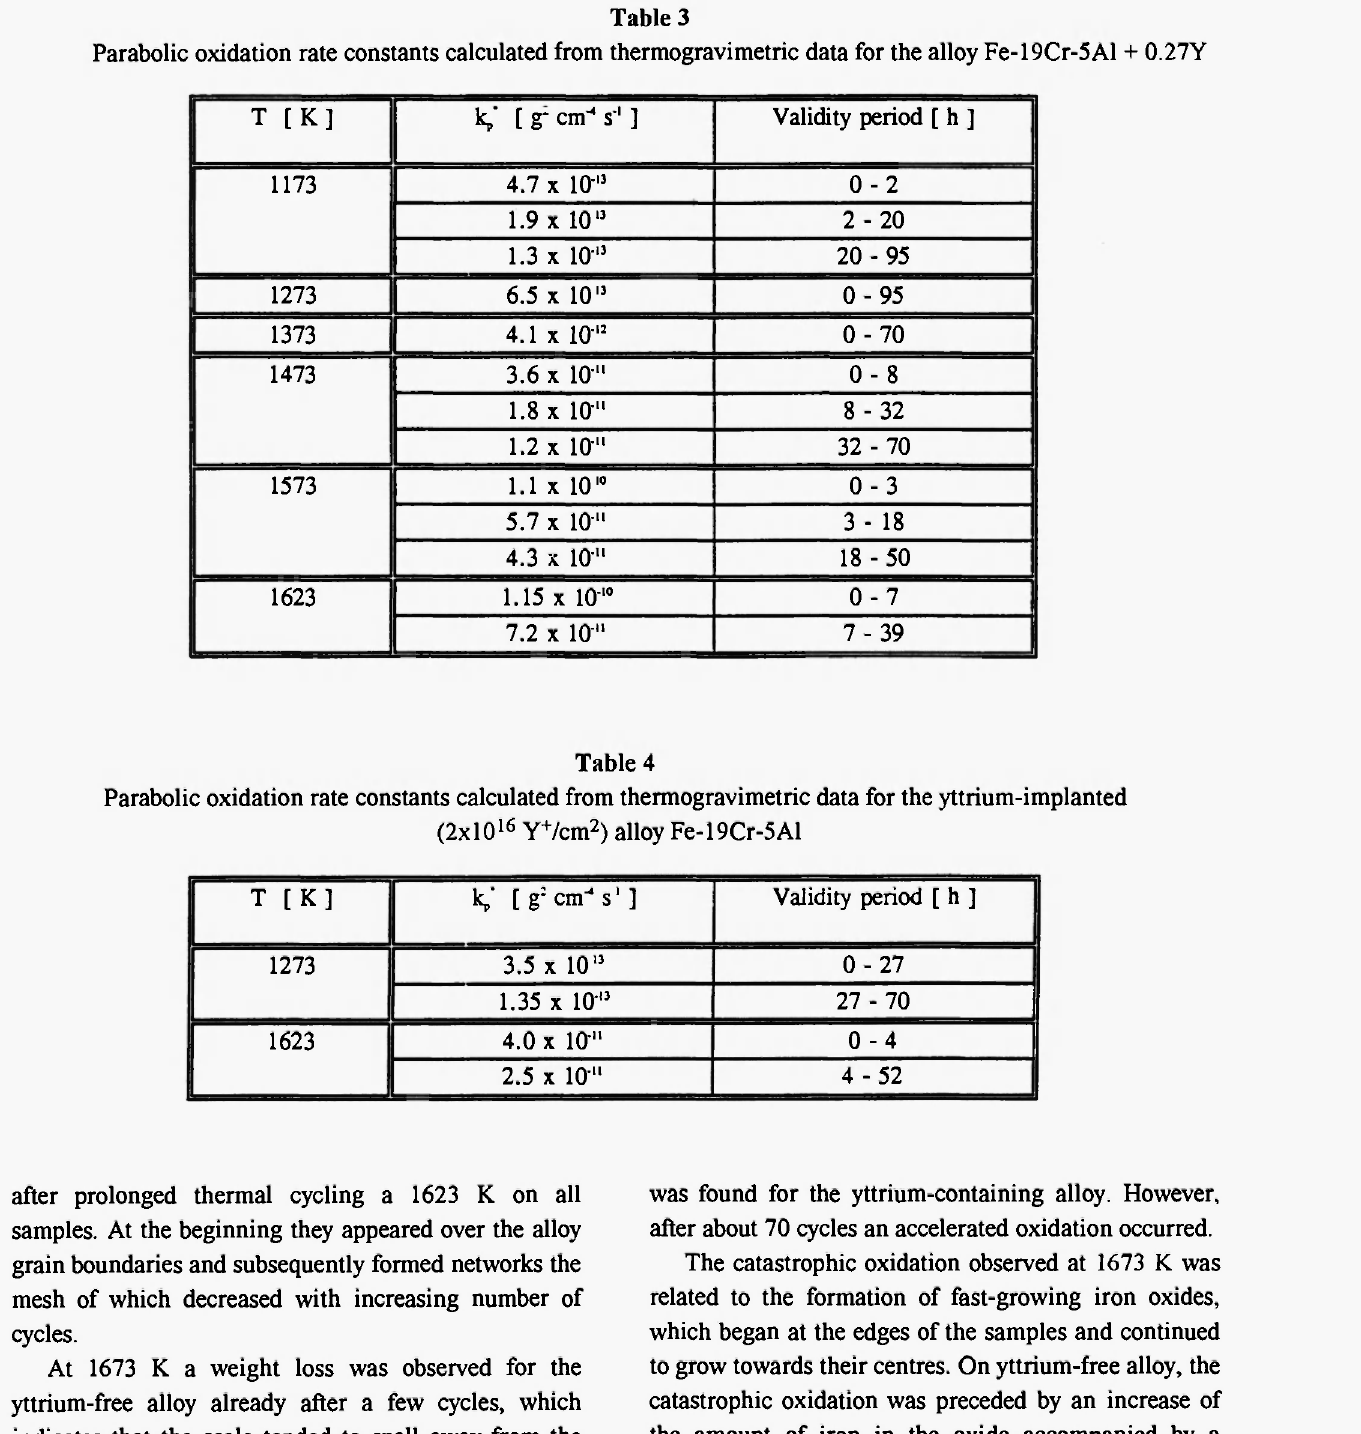
Parabolic oxidation rate constants calculated from thermogravimetric data for the alloy Fe-19Cr-5Al + 0.27Y